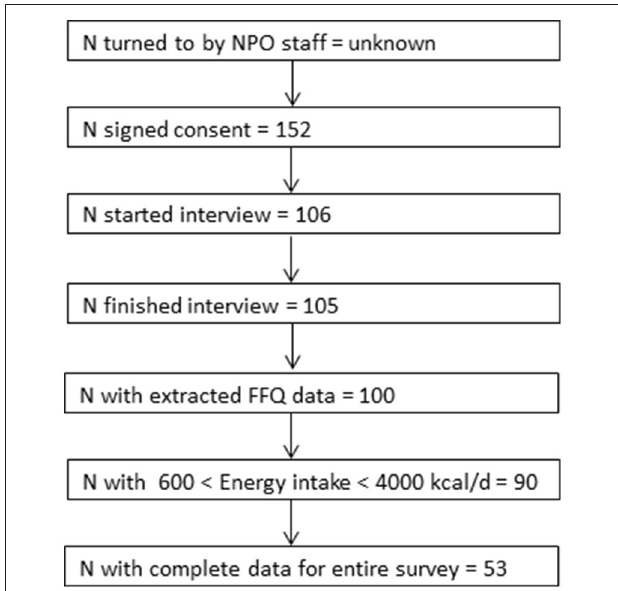
FIGURE 1 | Study population flow chart.